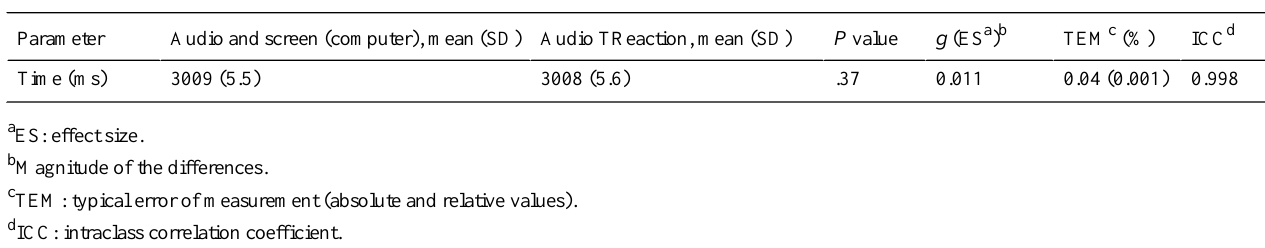
Table 2. Mean and standard deviation for the comparison of the repeated measures of the audio emission time and the screen change of the simulator, as well as the capture of the audio system obtained with the TReaction app